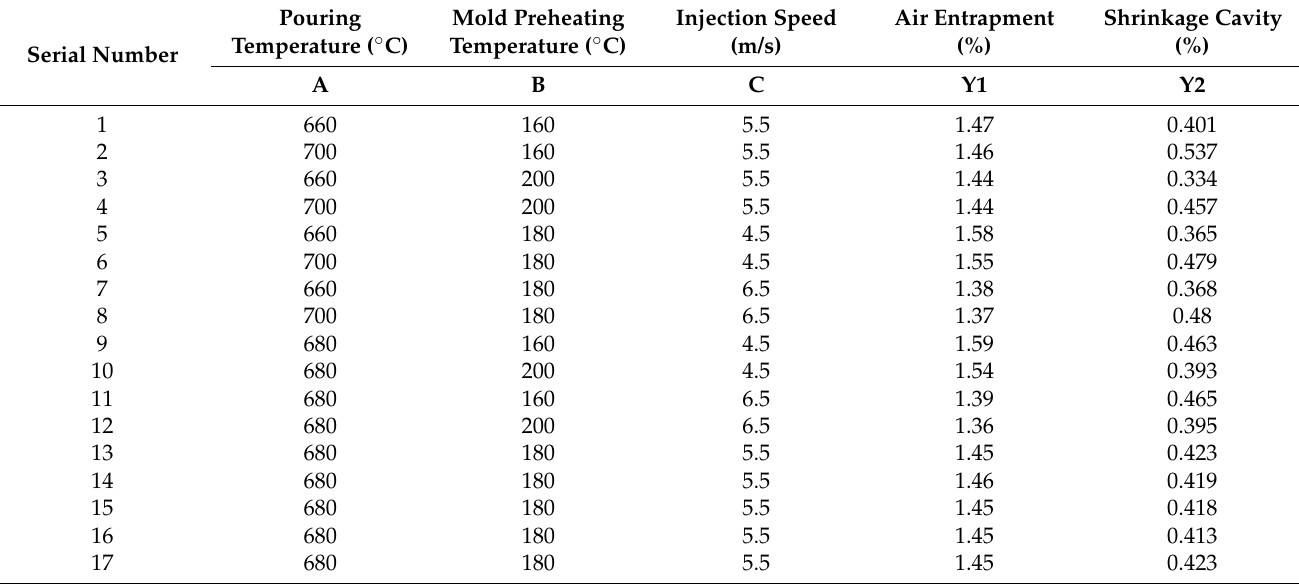
Table 3. Experimental table of response surface and statistics of results.